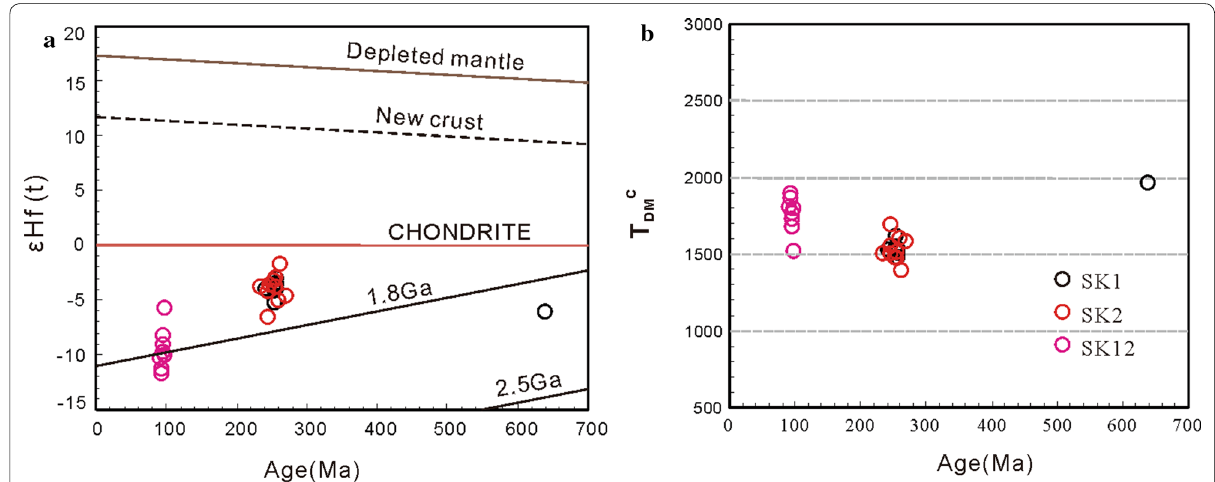
Fig. 10 εHf(t) vs. U–Pb ages ( a ) and Plots of TDMC vs. U-Pb ages, ( b ) for zircon grains from